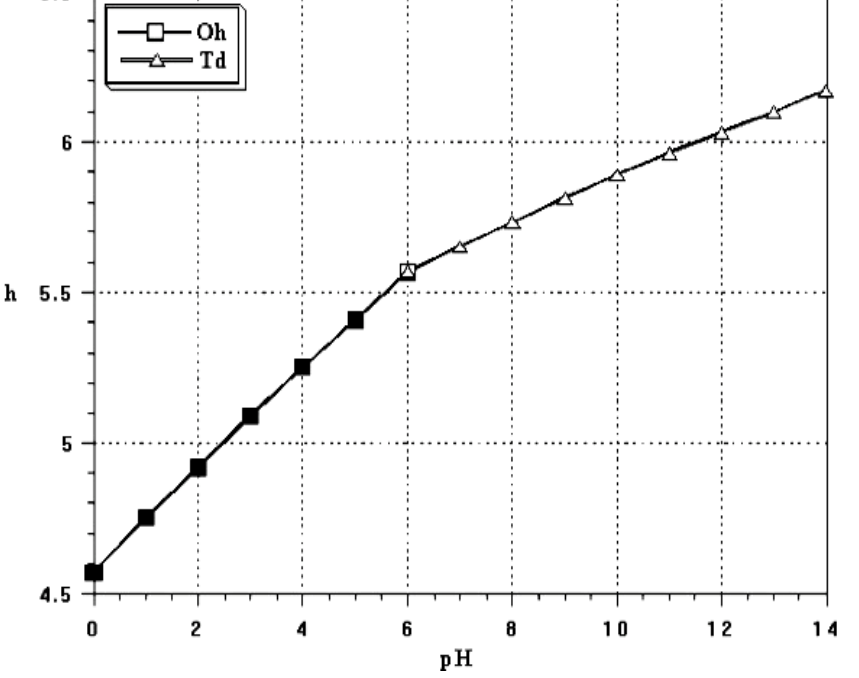
Figure 2. Hydrolysis ratio 'h' of V(V) precursors [V(OH)